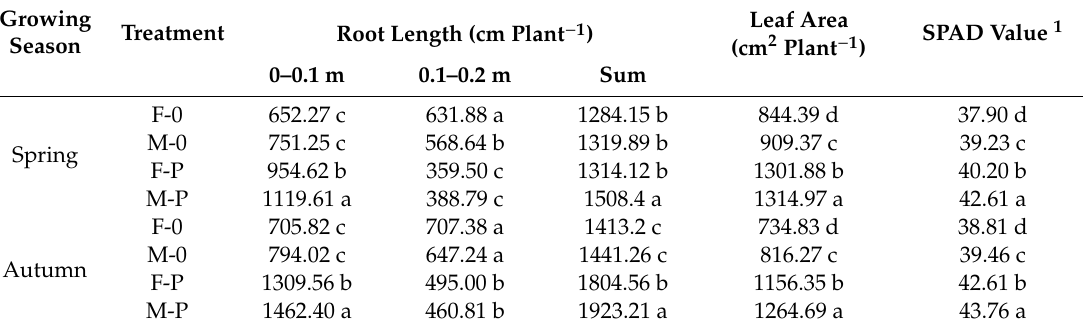
Table 2. Pakchoi morphology, including root length of root system in 0–0.1 m and 0.1–0.2 m and leaf area and SPAD value under di ff erent water management techniques in spring and autumn